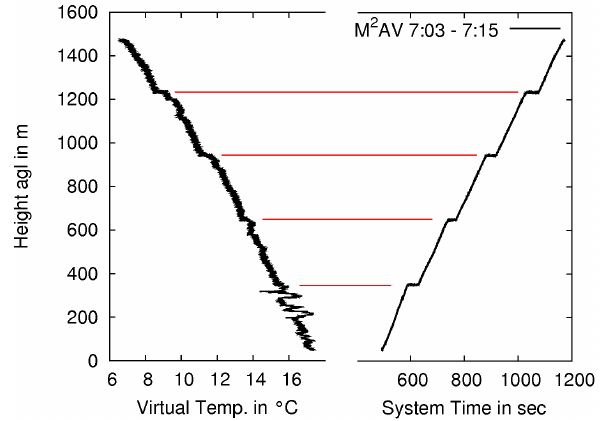
Fig. 11. Measured virtual temperature and recorded system time plotted over height a.g.l. The data was obtained during the first pro- file performed on 21 July 2009 near the MOL-RAO. Red horizontal lines mark sections of horizontal